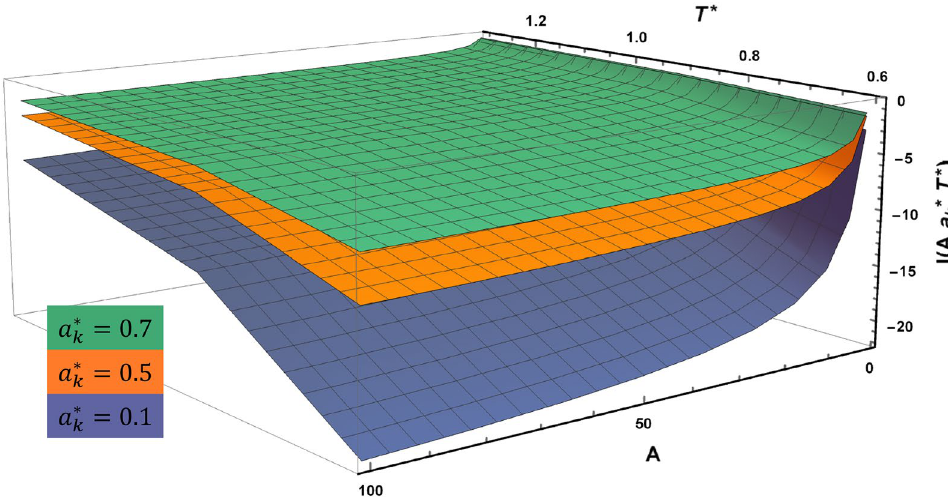
Figure 4. 3D diagram of I ( A , a ∗ k , T ∗ ) versus the reduced area and temperature for different values of the reduced Kihara